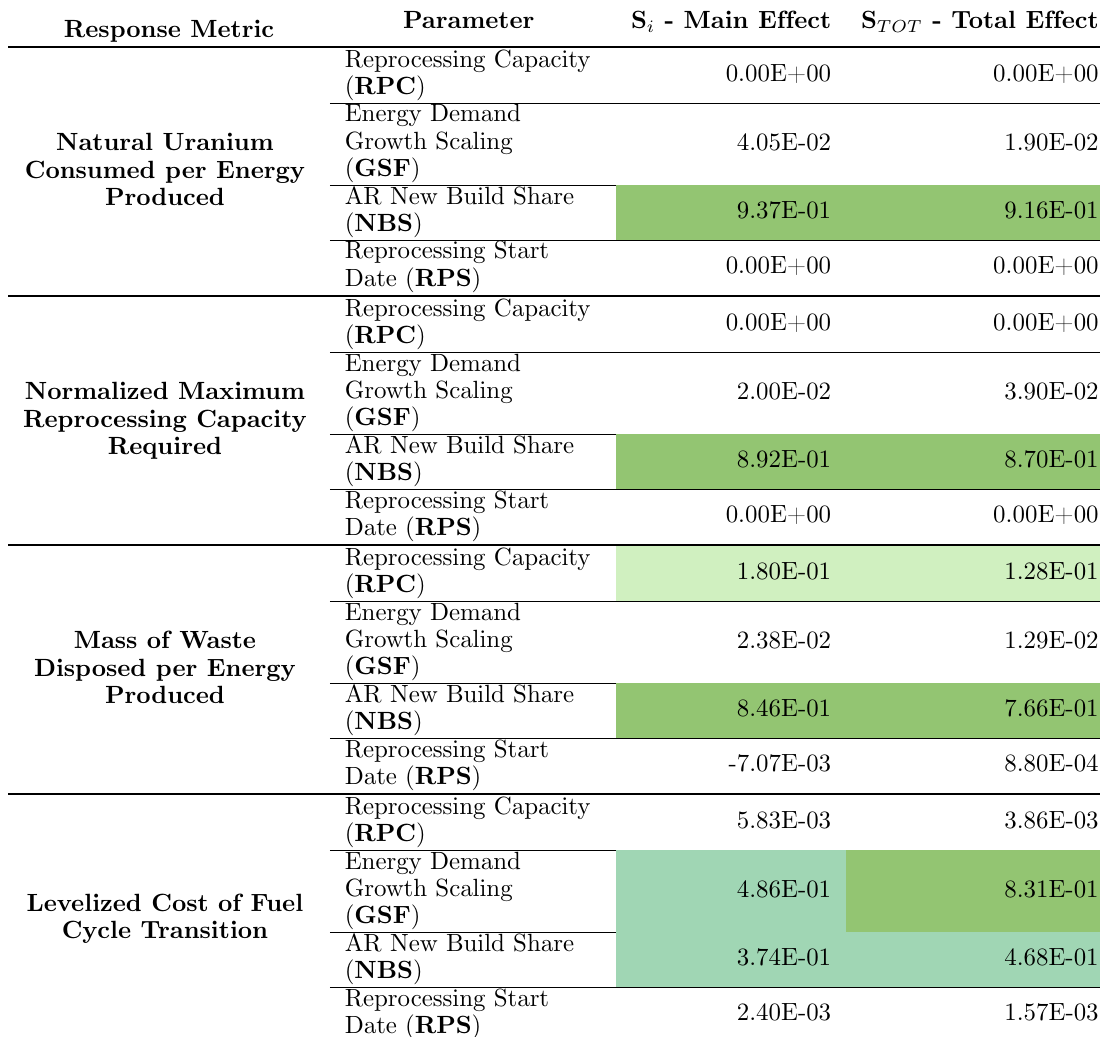
Table 3. Main effect indices and total effect indices for the limited parameter space